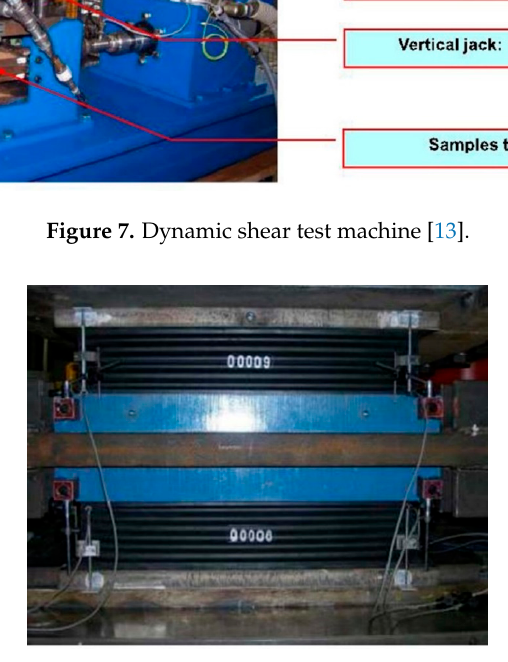
Figure 9. Dynamic shear test assembly [9]. Note that, even though there are design criteria for seismic isolation systems currently, there are no standards that set protocols for manufacturing procedures and certification of bearings. This issue should be addressed in the future.